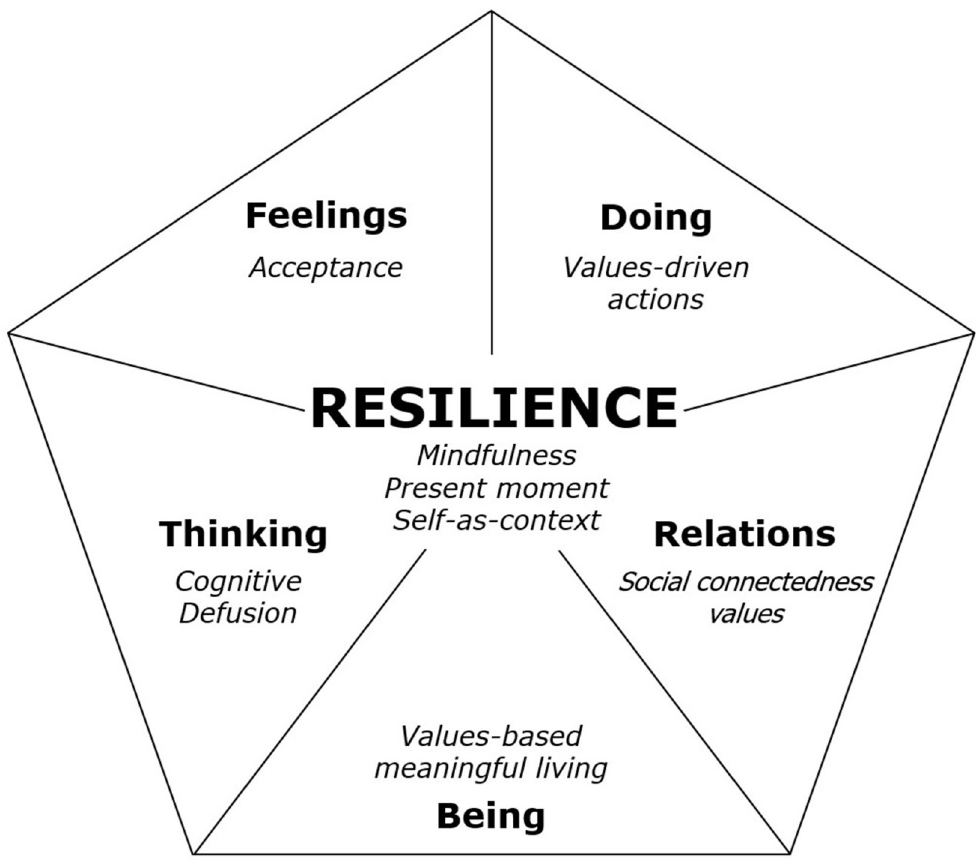
Fig 3. The READY resilience shield. Note. Life domains are in bold, ACT processes reflecting resilience protective factors (italics) are reported in the relevant life domain (shield clove) or in the centre of the shield if they have a central pivoting